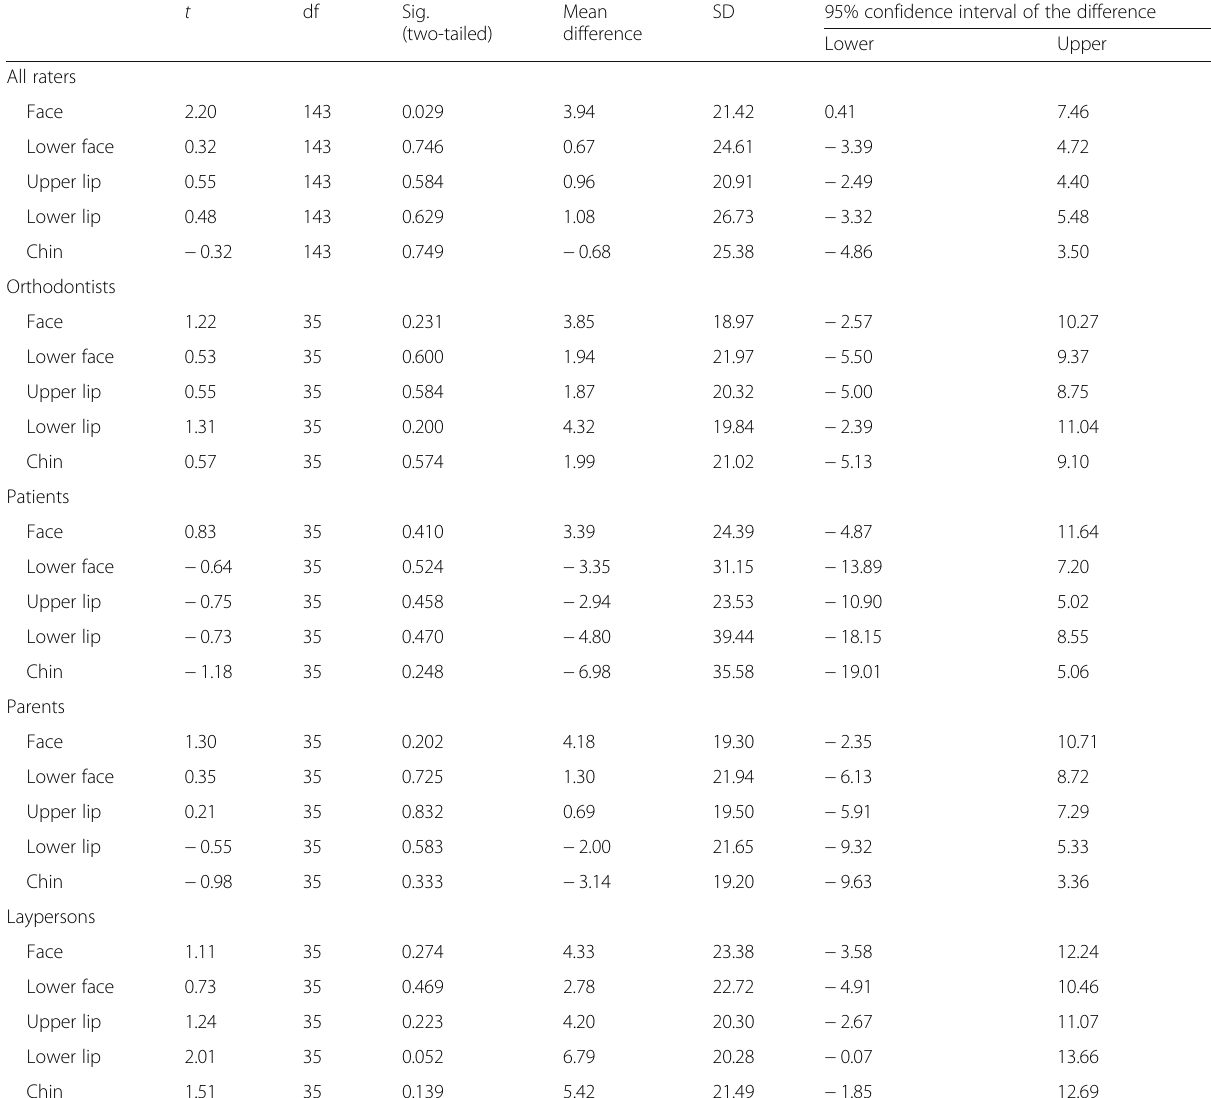
Table 2 Mean differences between two repeated ratings performed by 12 raters and one-sample t test testing if the mean difference is significantly different from 0 (systematic error; P <